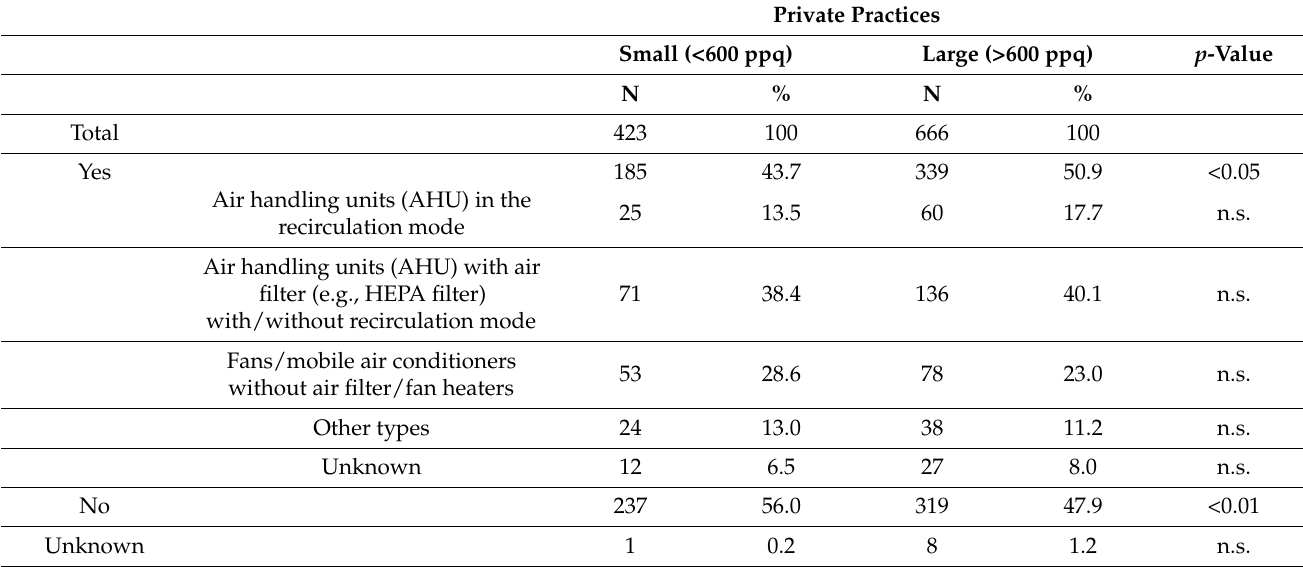
Table 6. Use of air ventilation systems.